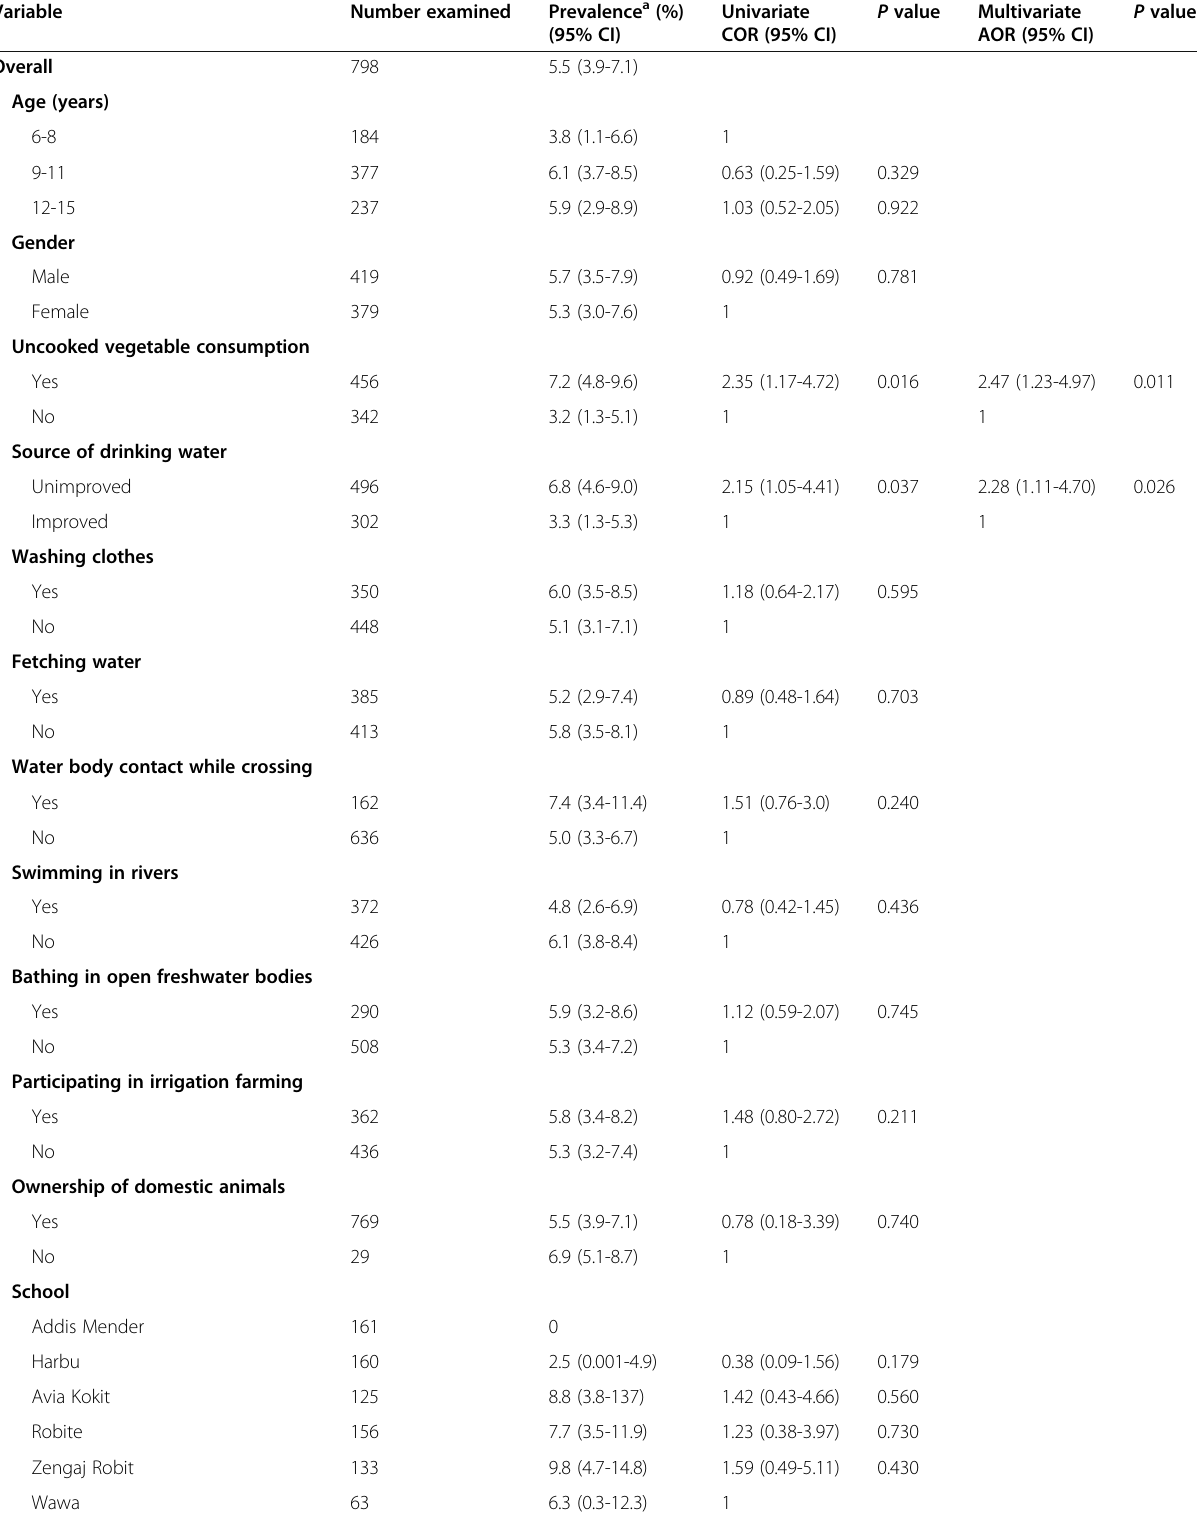
Table 2 Prevalence of Fasciola species infection among the school children in Amhara Regional State, Ethiopia